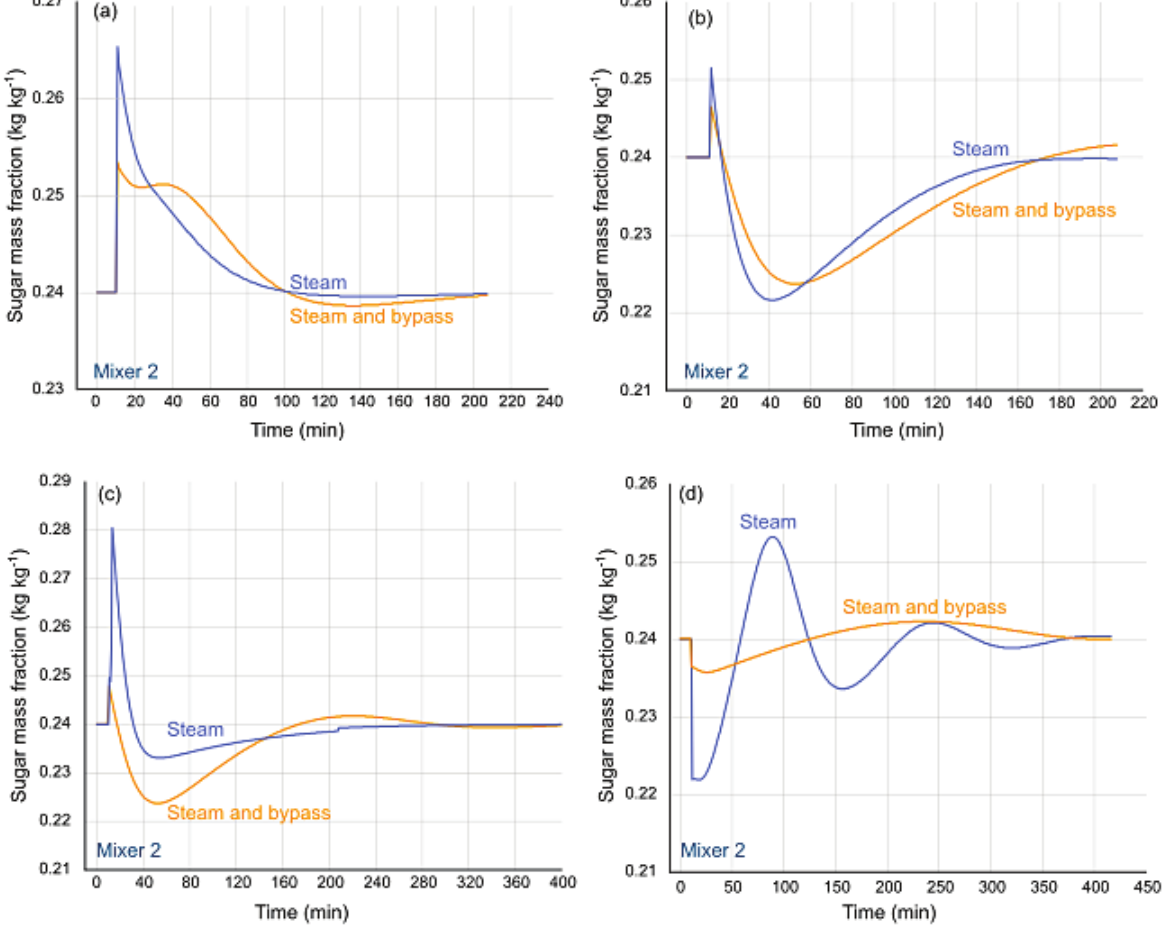
Fig. 10 – Responses of two different strategies for controlling the concentration of the output of the second mixer to simultaneous step disturbances in juice sugar concentration and temperature (a), juice volumetric flow rate and temperature (b), juice sugar con- centration, and volumetric flow rate (c), and a 30 % step disturbance in the glucose syrup volumetric flow rate (d). The strategies are PID controller manipulating steam flow rate fed to the first effect and the same PID controller coupled to a PI controller manipulat- ing splitter fraction